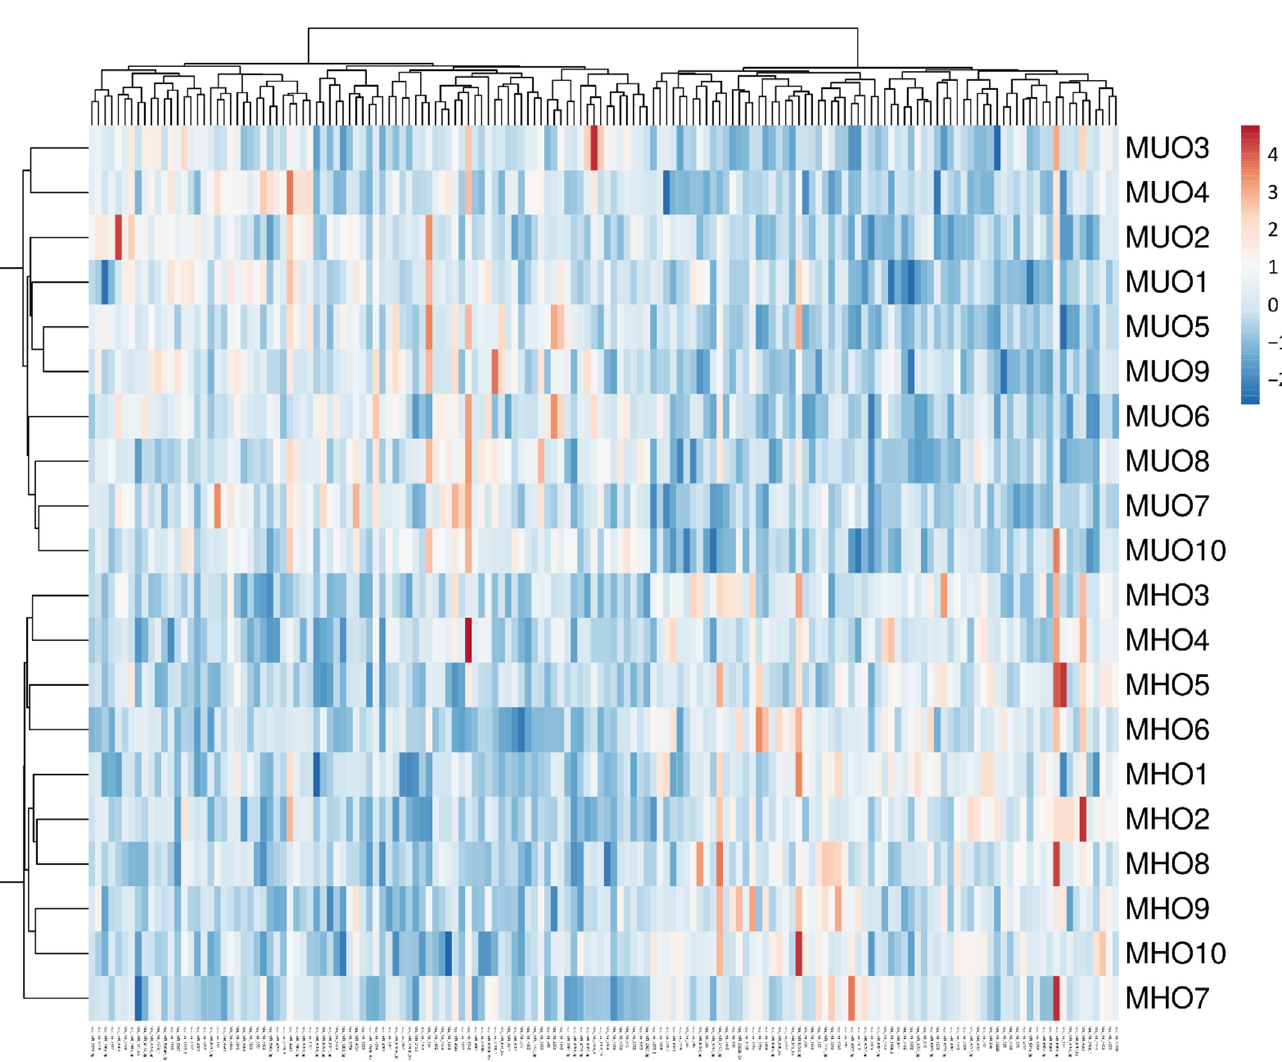
Figure 2. Hierarchical clustering of samples (MHO and MUO, n =10 in each group) based on summarized intensity values of the 159 differentially expressed circulating miRNAs. Log2 intensity values are shown in the bar scale. Rows are centred; unit variance scaling has been applied to rows. Both rows and columns are clustered using correlation distance and average linkage. 20 rows, 156 columns. Annotations on the heatmap show clustering of the samples.